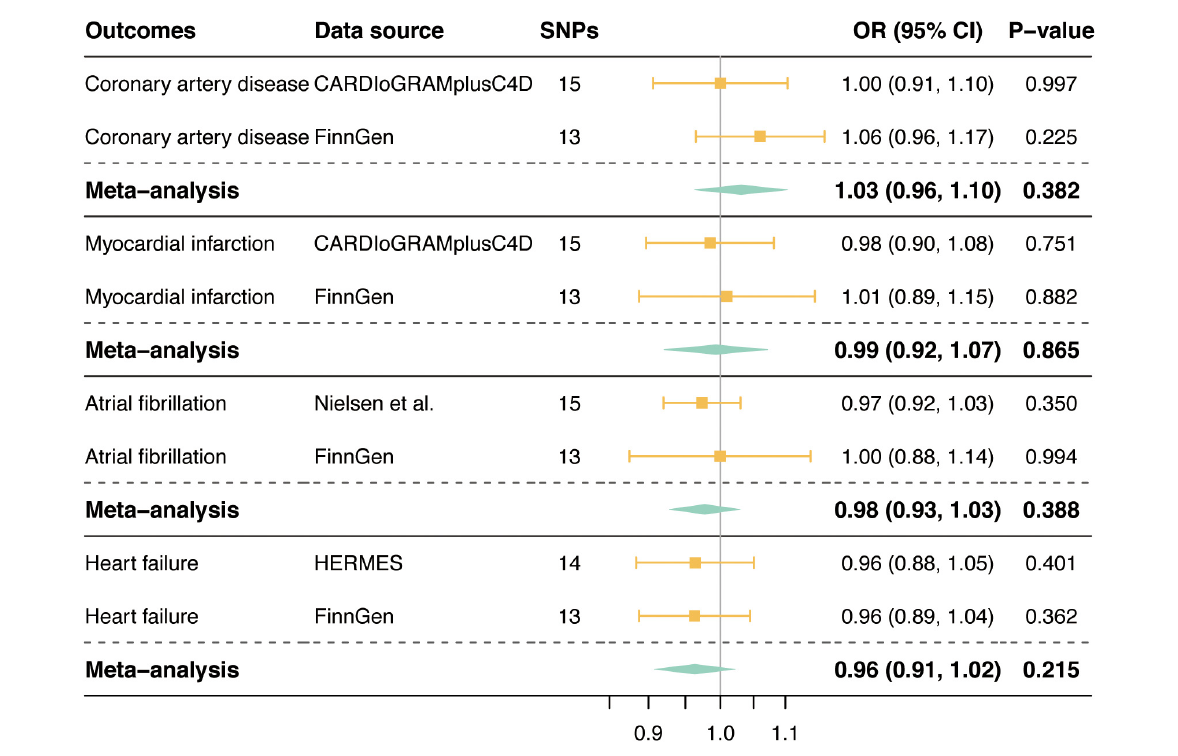
FIGURE3 Mendelian randomization associations of tea consumption with risk of cardiovascular diseases. SNPs, single nucleotide polymorphisms; OR, odds ratio; CI, confidence interval; CARDIoGRAMplusC4D, Coronary ARtery DIsease Genome-wide Replication and Meta-analysis (CARDIoGRAM) plus The Coronary Artery Disease (C4D) Genetics; HERMES, Heart Failure Molecular Epidemiology for Therapeutic